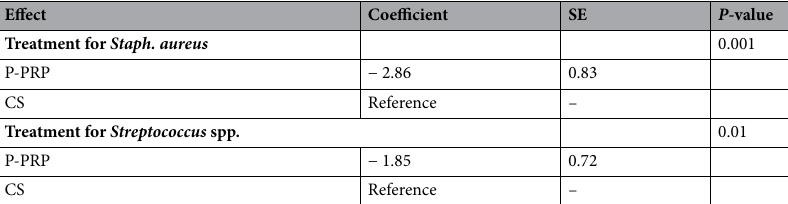
Treatment for Streptococcus spp.